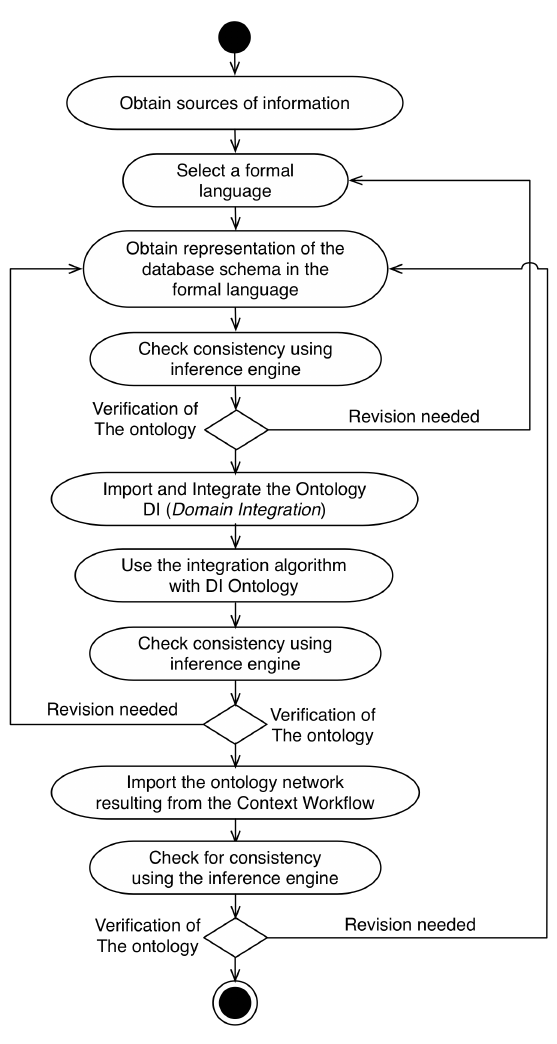
Figure 6. Overview of Domain